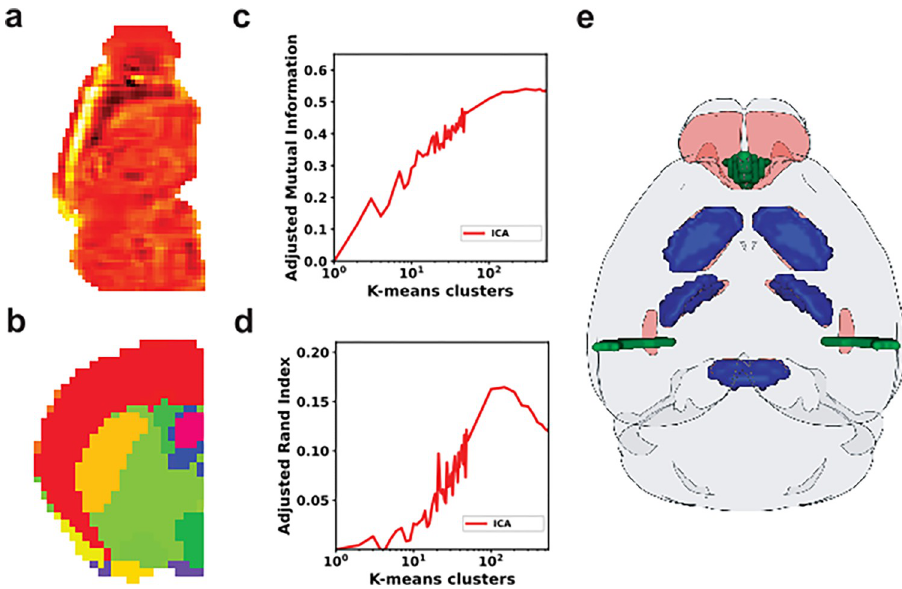
Fig 1. Representation learning on AMBA with ICA. In a whole brain analysis of 100 ICA derived representations (a) A selected representation shows activity across the brain with a bright anatomical like region. (b) K-means clustering of the ICA representations appears more selectively anatomical (K = 200). (c) AMI and (d) ARI of clustered components, compared to neuroanatomy, using K-means clustering with K ranging from 1 to 50 and from 50 to 550 with a step of 50. (e) 3D representation of K-means clusters with selected top overlapping clusters (in blue) with brain regions (Olfactory Tubercle, Reticular nucleus of the Thalamus, and Pontine Gray) in red and low overlapping clusters (in green) with brain regions (Basolateral Amygdalar Nucleus, posterior part and Main Olfactory Bulb) in red using Dice similarity coefficient.